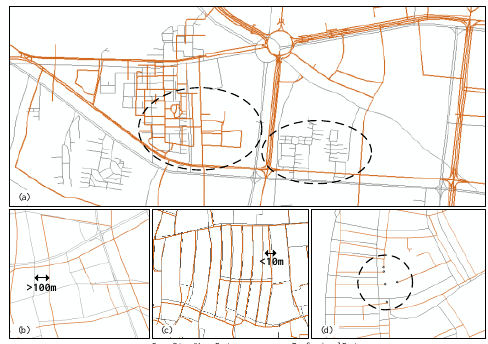
Professional Data